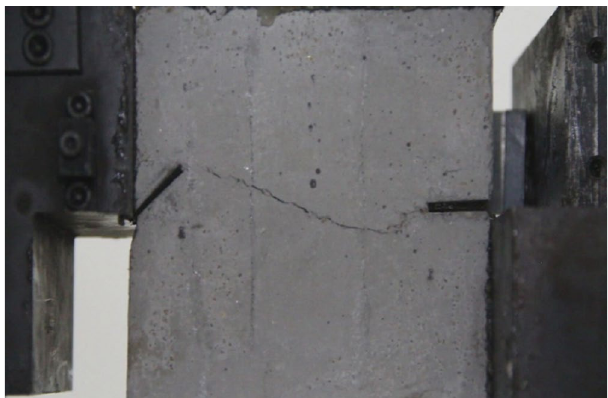
Figure 18. Fracture evolution diagram of fractured rock mass, fractures appeared.